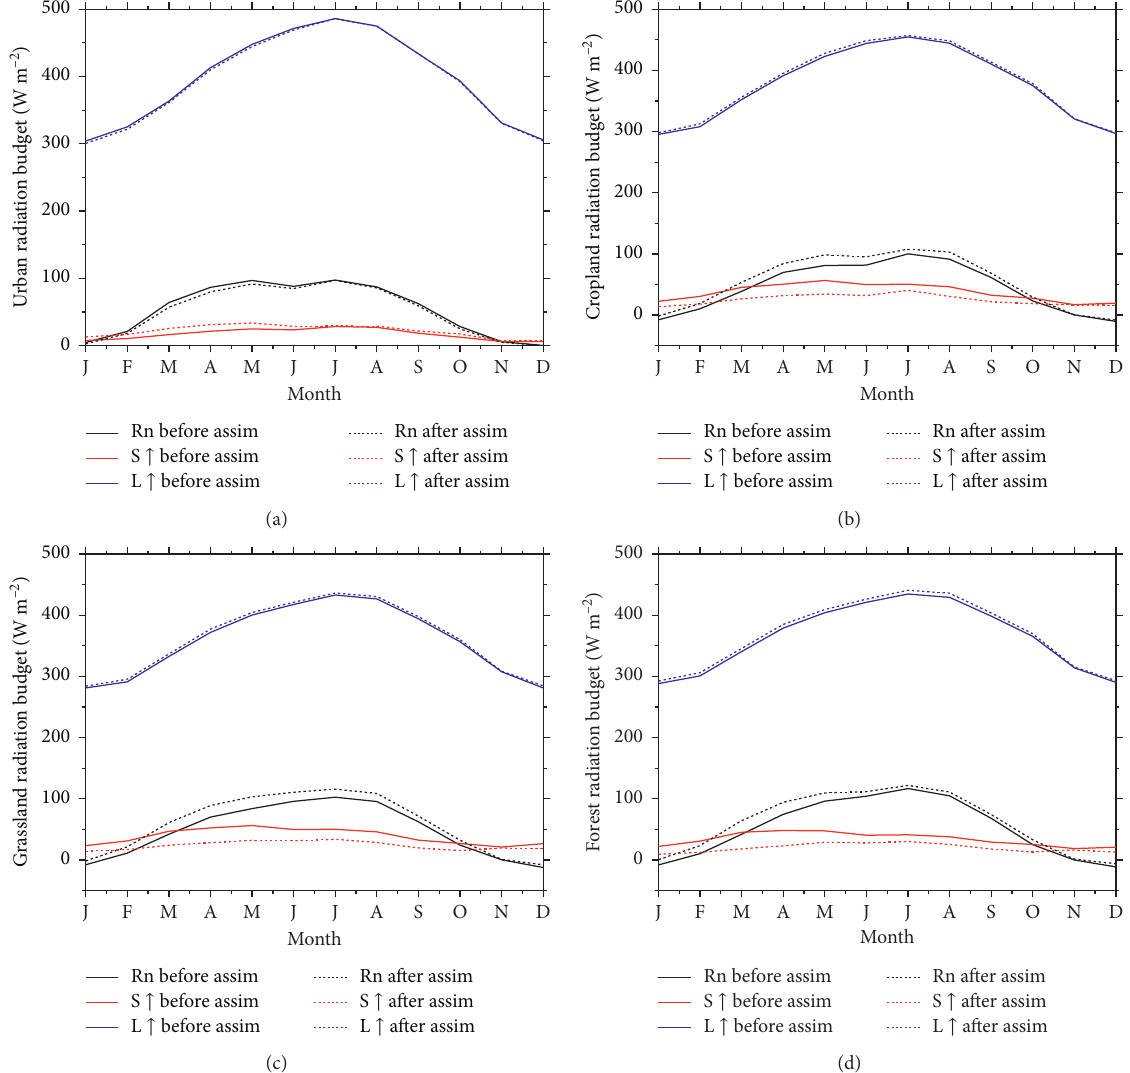
Figure 13: Spatial average of the monthly average radiation budget simulations before and after assimilation for the four main LUCs: (a) urban; (b) cropland; (c) grassland; (d)